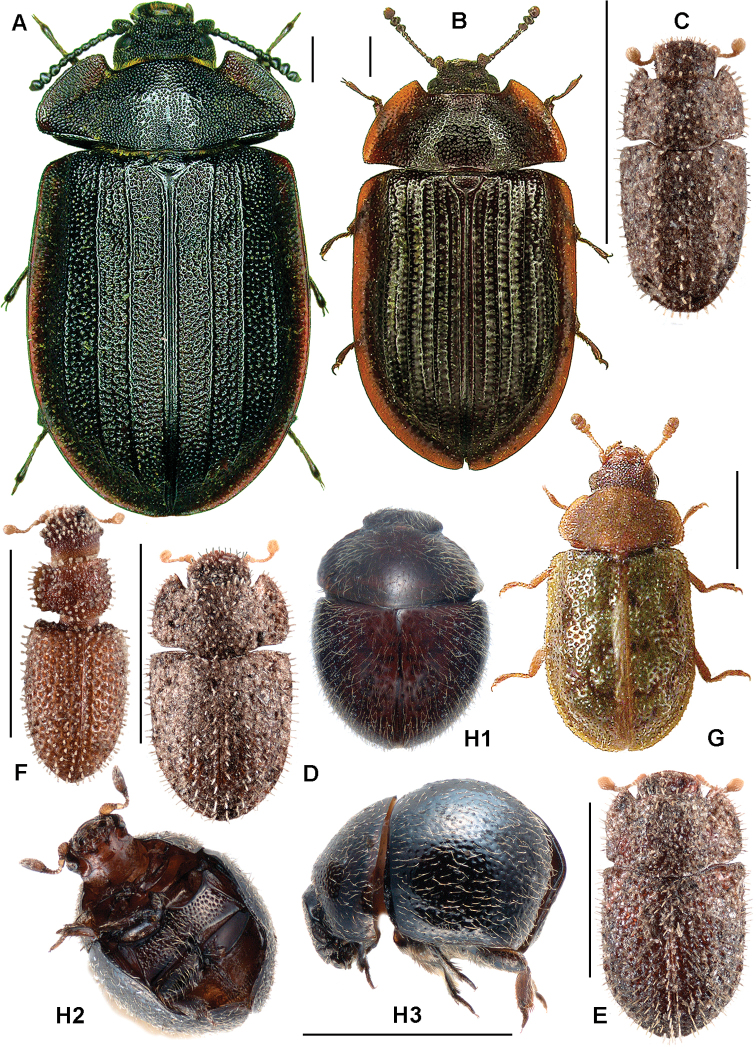
A
Peltis (syn. Zimioma, Ostoma) grossa
B
Peltis (syn. Ostoma) ferruginea
C
Colydiopeltis loebli
D
Colydiopeltis compactum
E
Colydiopeltis burckhardti
F
Parapeltis australicum
G
Protopeltis viridescens
H
cf.
Globorentonium plaumanni, Brazil (1–3: three different specimens from the same locality).